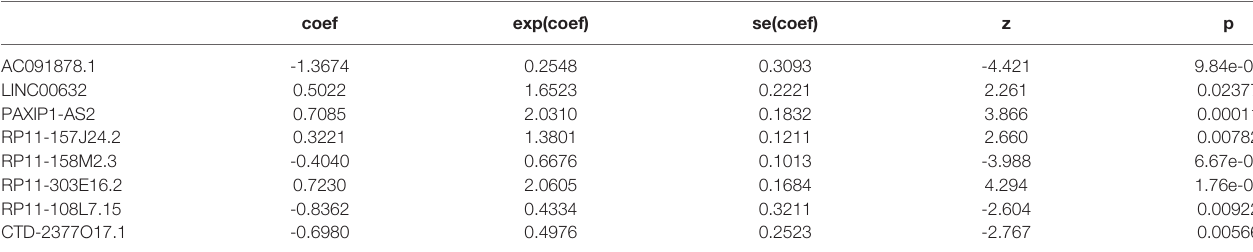
TABLE 2 | The eight prognostic m5C-related